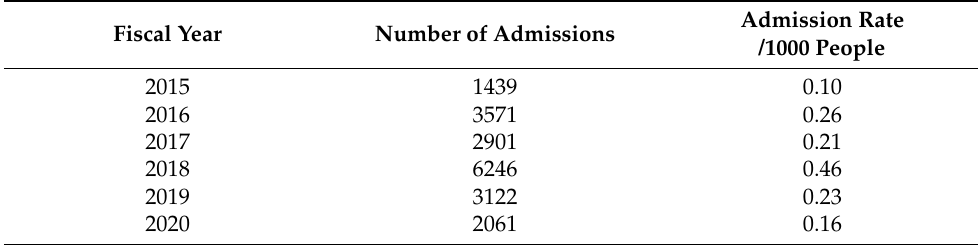
Table 3. Admissions of Thai children due to RSV-related LRTI in fiscal years 2015 to